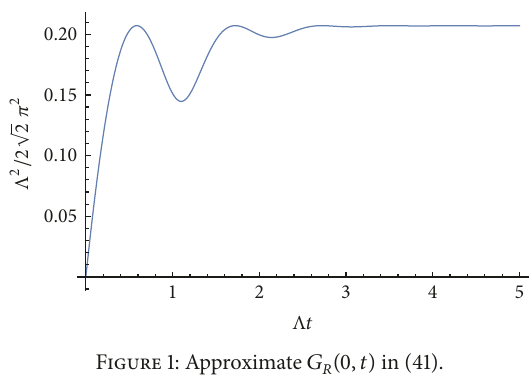
Figure 1: Approximate 𝐺 푅 (0, 𝑡) in (41).